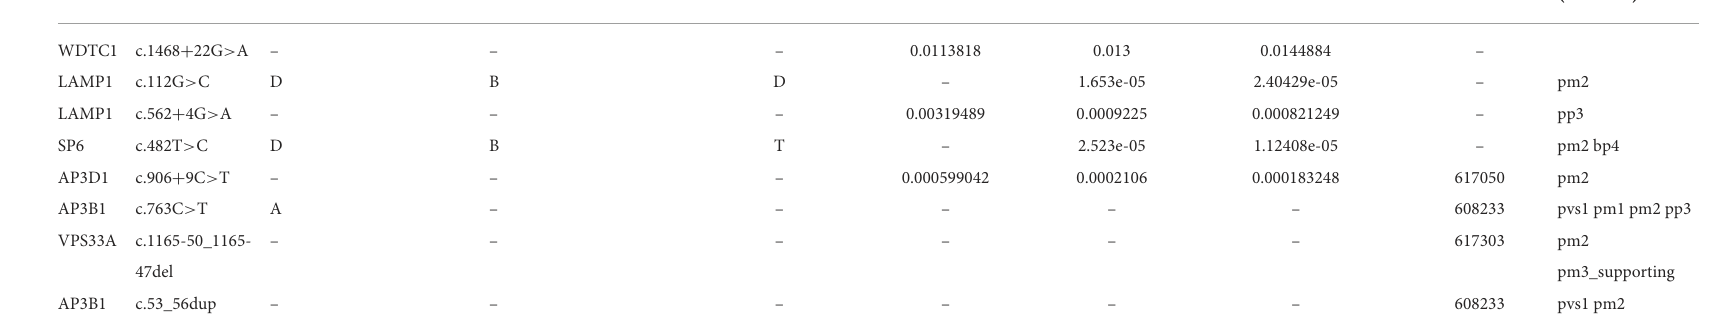
TABLE 1 Eight heterozygous variants in six genes identified by whole-exome sequencing (WES) in the proband.